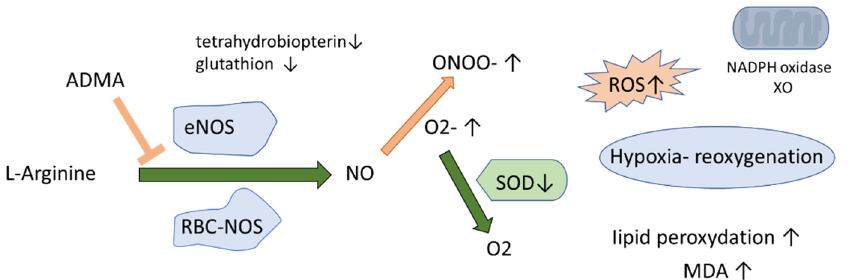
Figure 1. Oxidative stress in OSA. Abbreviations: RBC-NOS: red blood cell nitric oxide synthase; ADMA: asymmetric dimethylarginine SOD: superoxide dismutase; XOD: xanthine oxidase; ONOO − : peroxynitrite; O 2 − : superoxide; ROS: reactive oxygen species; MDA: malonyldialdehyde; eNOS: endothelial nitric oxide synthase, RBC-NOS: nitric oxide synthase in the erythrocyte.